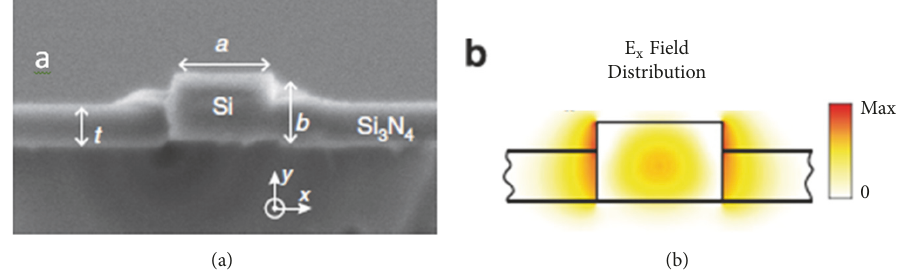
Figure 18: (a) Cross-section of a linear nanowaveguide of width 313 nm and height 194 nm; (b) computer model of the field distribution of its guided wave [adapted from [21]].